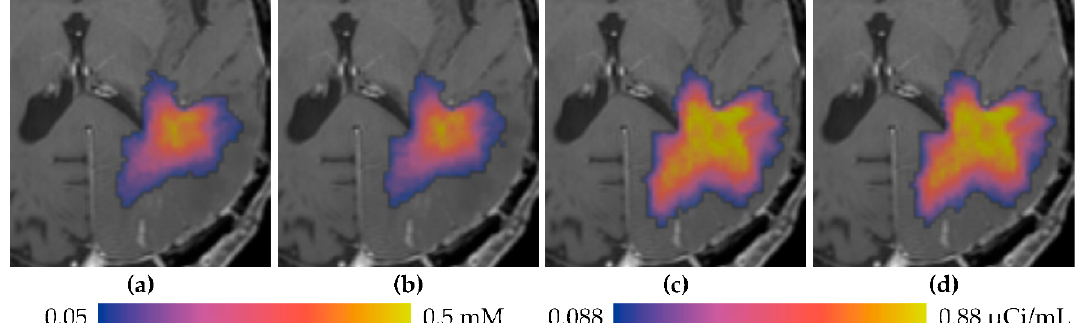
Figure 8. Di ff usion has little impact on distribution. Simulations of Gd-DTPA and 124I-HSA concentrations with and without di ff usion (72 h, MR1-1 Patient 7. ( a ) Simulated Gd with di ff usion. ( b ) Simulated Gd without di ff usion. ( c ) Simulated HSA with di ff usion. ( d ) Simulated HSA without di ff